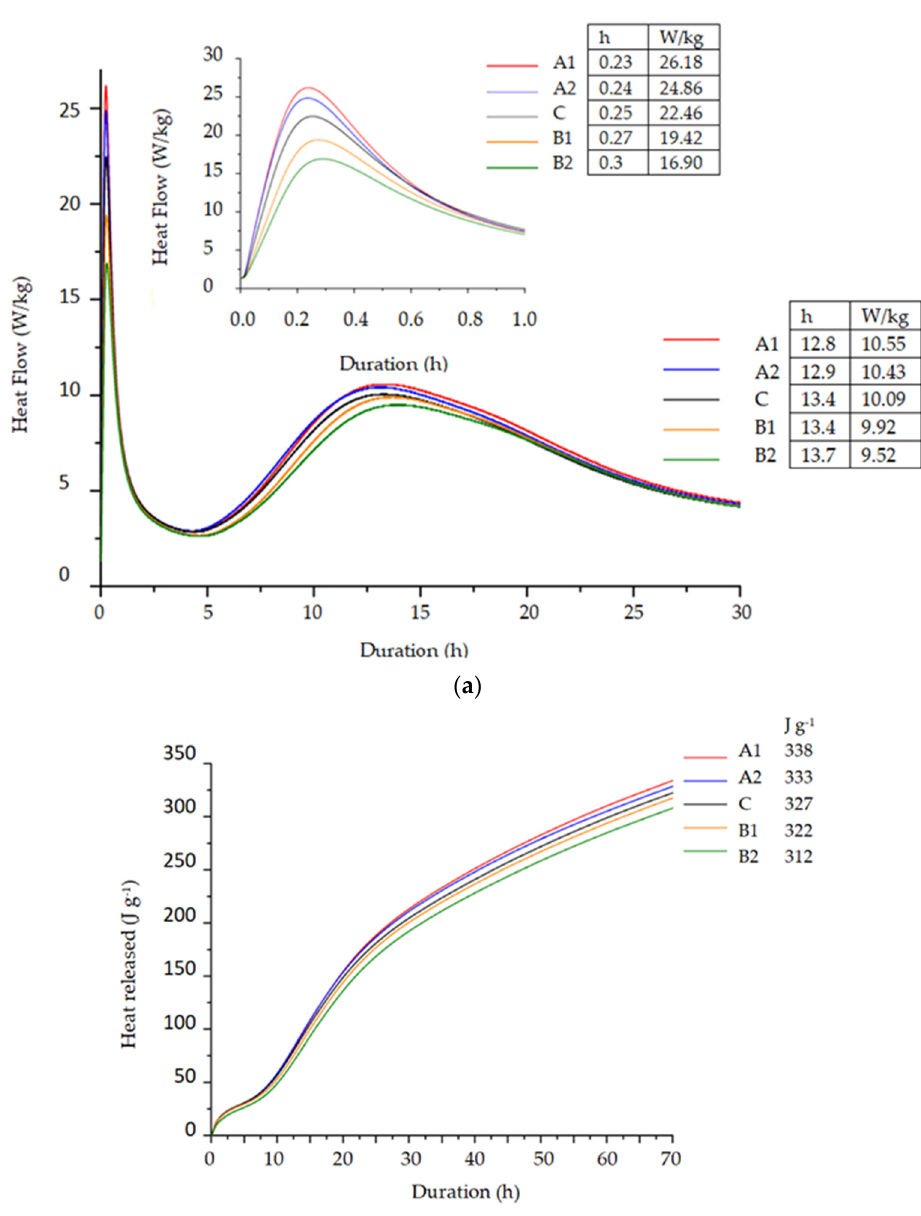
Figure 6. Heat release rate ( a ) and amount of released heat ( b ) during 70 h of hydration of blended cement pastes with PVA fibers